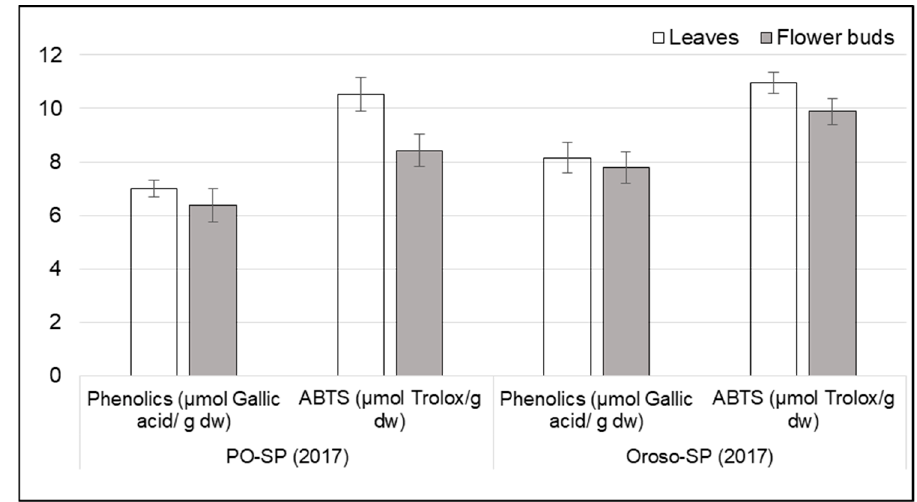
Figure 4. Phenolic content ( µ mol Gallic acid/g dw) and antioxidant activity measured with ABTS assays ( µ mol Trolox/g dw) of nine B. rapa varieties measured in leaves (turnip greens) and flower buds (turnip tops) in two locations from Spain in 2017–2018 growing season. Significant differences among environments ( p < 0.001) .